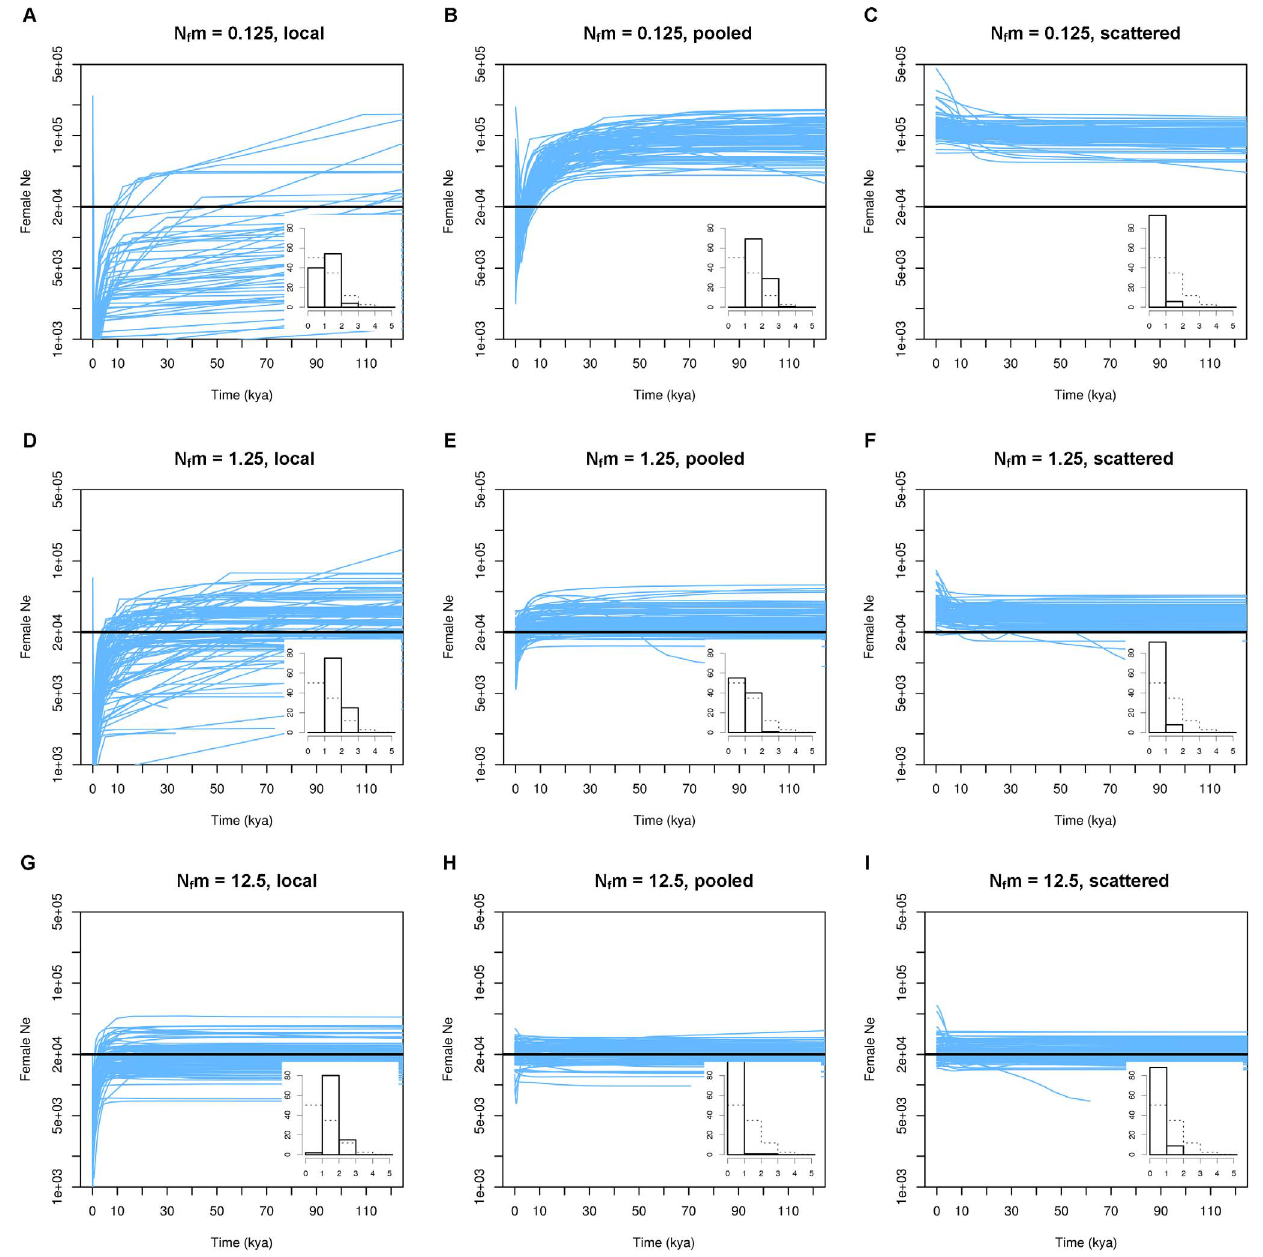
Figure 1. The structure effect in a 40-deme constant-size island model. For each scenario, 100 replicate data sets were generated and analysed with EBSPs. Light blue lines represent the median inferred female effective population size through time from each replicate. Time is measured in kya or thousands of years ago and is based on a molecular clock for buffalo D-loop sequences. Bold black lines represent the simulated size of the structured population (500 females * 40 demes=20,000 females). Insert into each panel is a histogram of PSC values (on x-axis; see main text) across replicates. Dashed lines show the prior distribution for PSC. The y-axis in the insert histograms marks the frequency of occurrence in each PSC bin out of 100